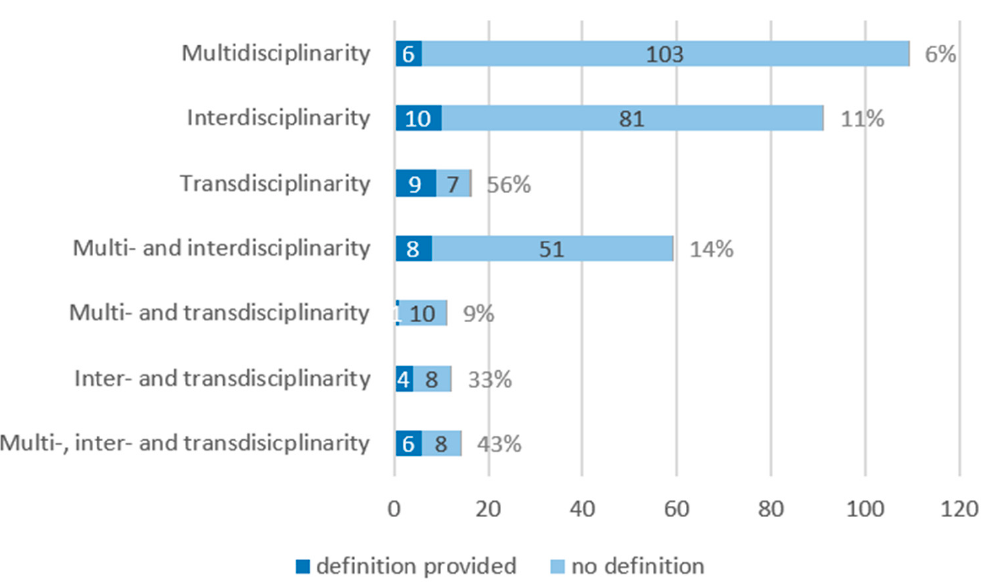
Figure 3. Concepts mentioned and defined in included articles ( n = 324).